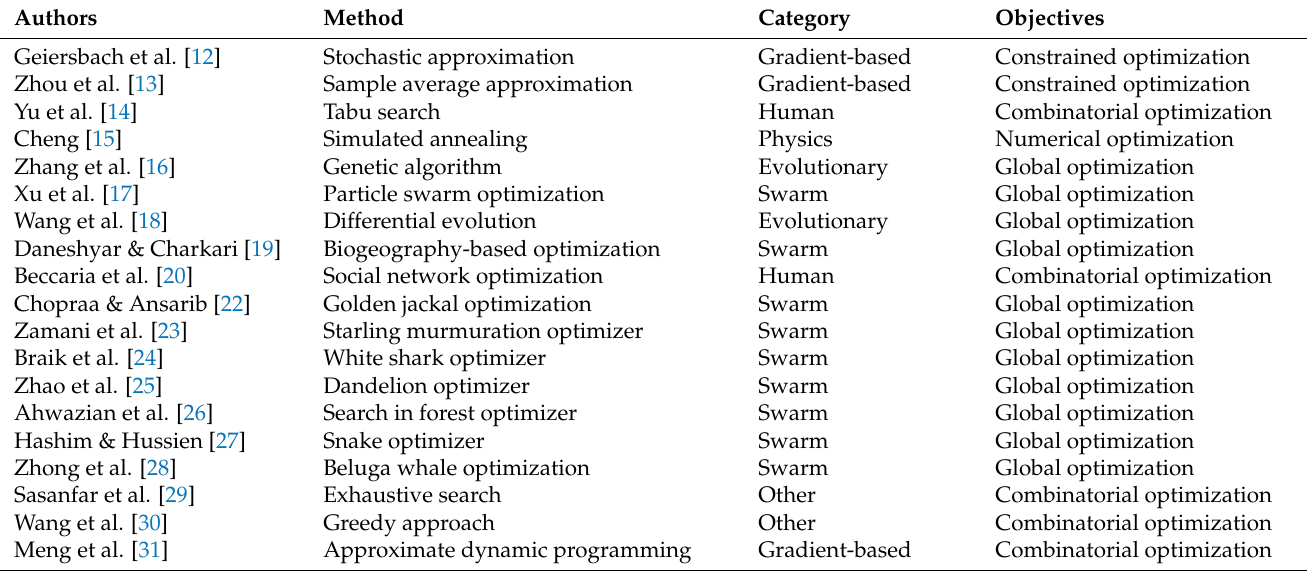
Table 1. Research gaps and contributions of the previous